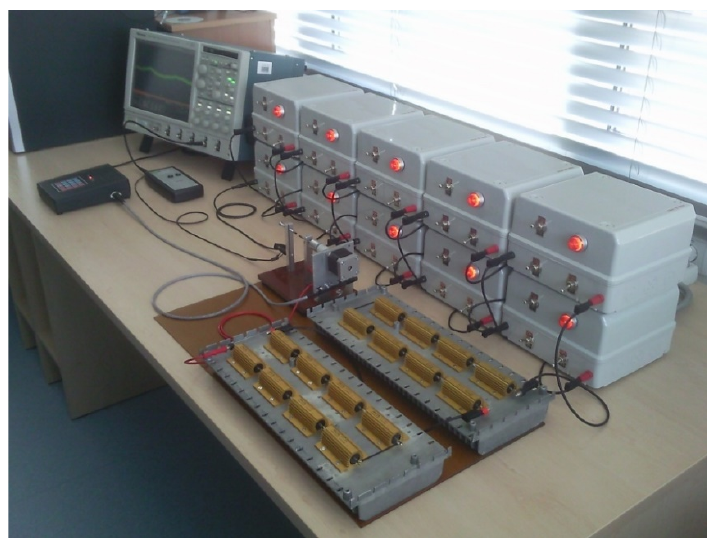
Figure 3. Block diagram of the measurement system.